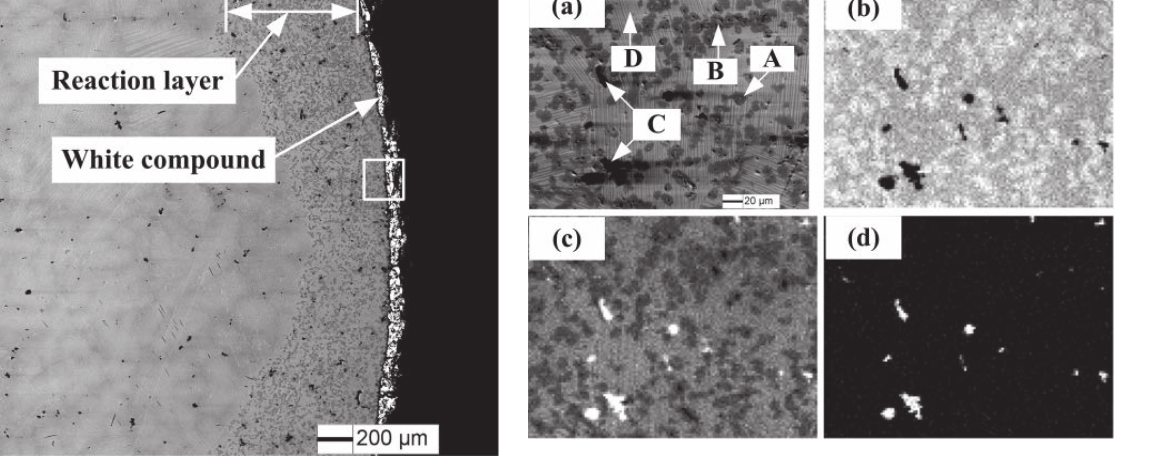
Fig. 2: SEM micrograph of the Ti-47Al-2Cr-2Nb sample obtained by zirconia mould.